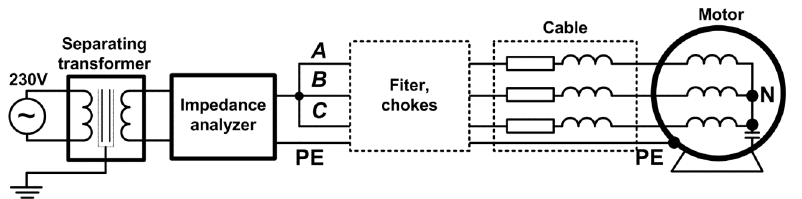
Figure 13. A common-mode impedance Z C measurement setup.